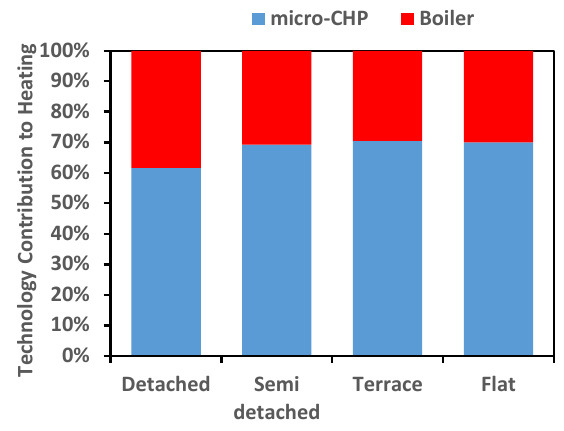
Figure 4. Non-incentivised design without thermal energy storage (TES).